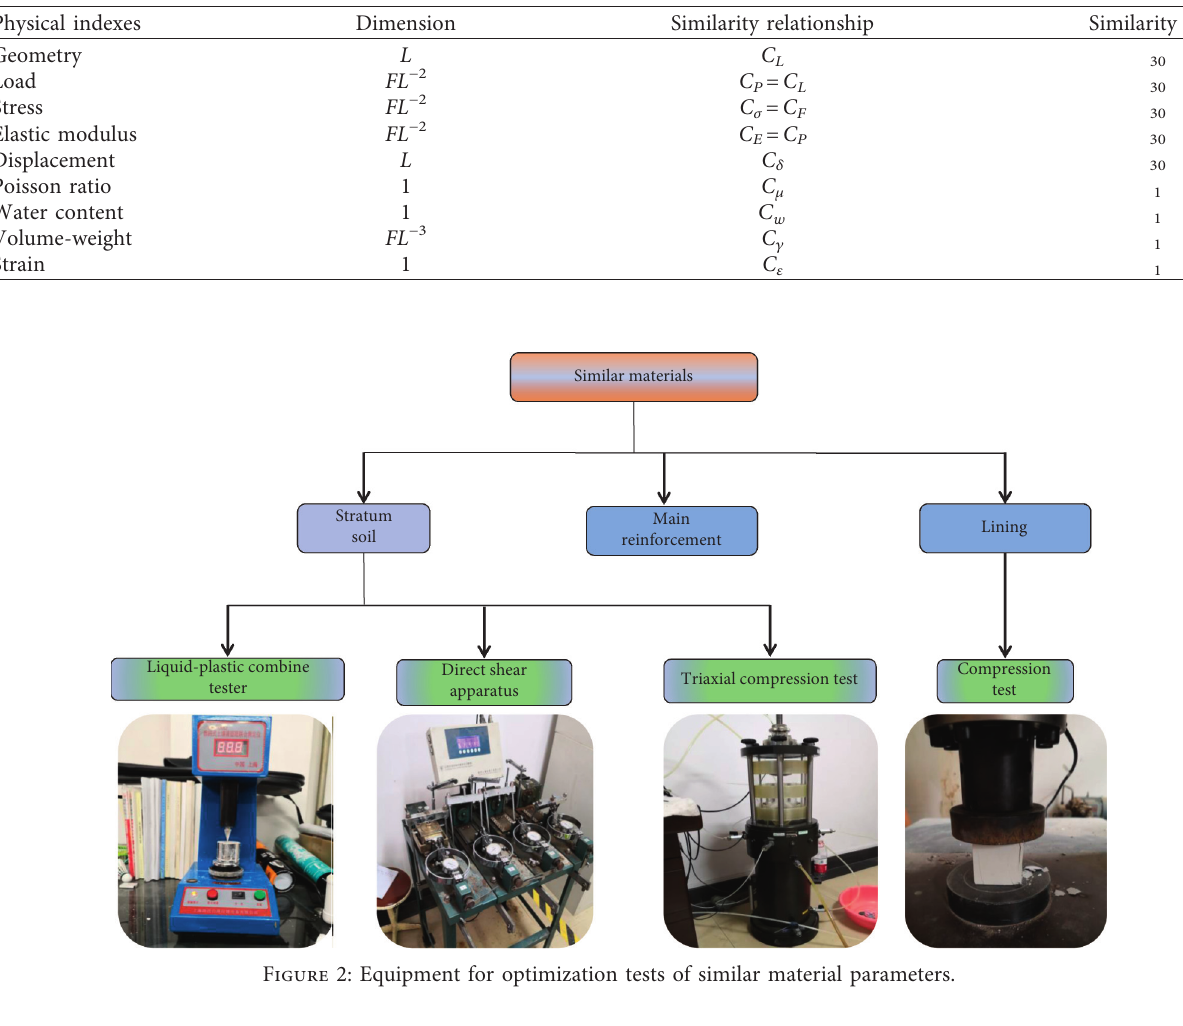
Table 1: Similarity parameters of model